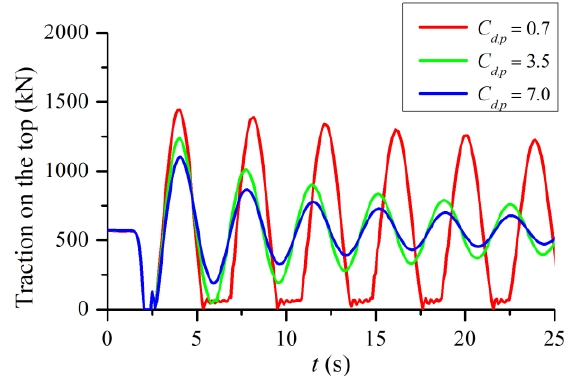
Figure 11. Influence of the payload’s drag coefficient on the snap load of the cable–payload system in 300 m depth, with a structural damping ratio of 0.1.